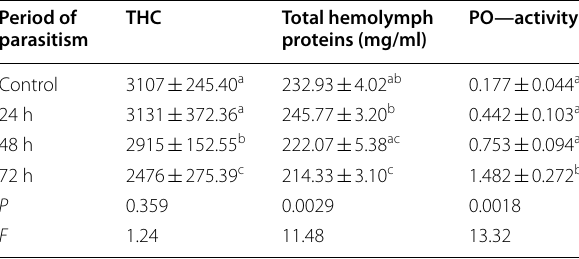
Means followed by the same letter in the same column are not significantly different ( P > 0.05); n